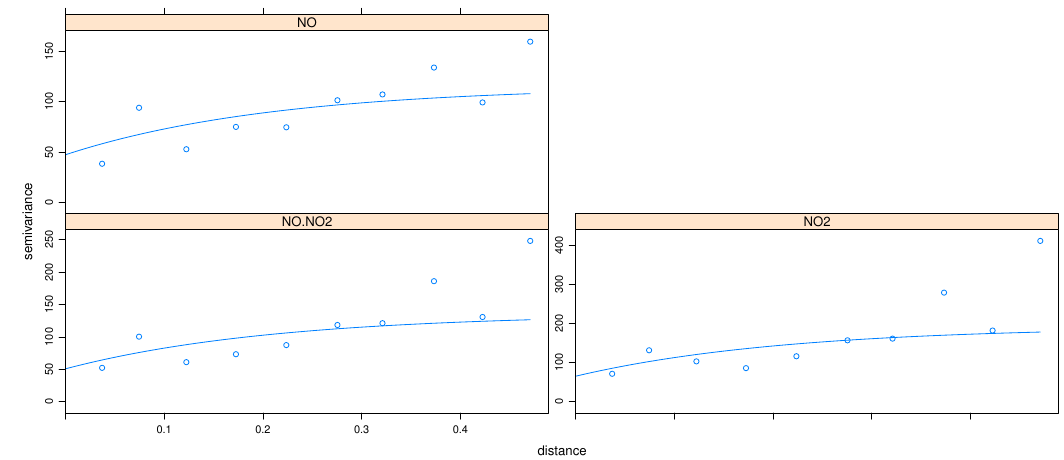
Figure 10. Variogram-crossvariogram matrix of the classical variogram and cross-variogram estimations with the classical model of Example 3.